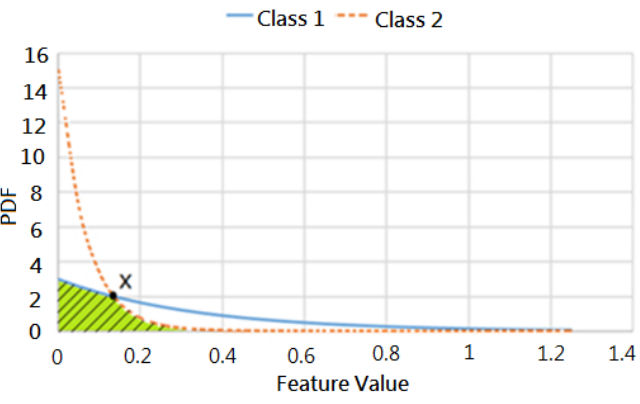
Figure 3. An intersection area under two probability density function (PDF) curves.